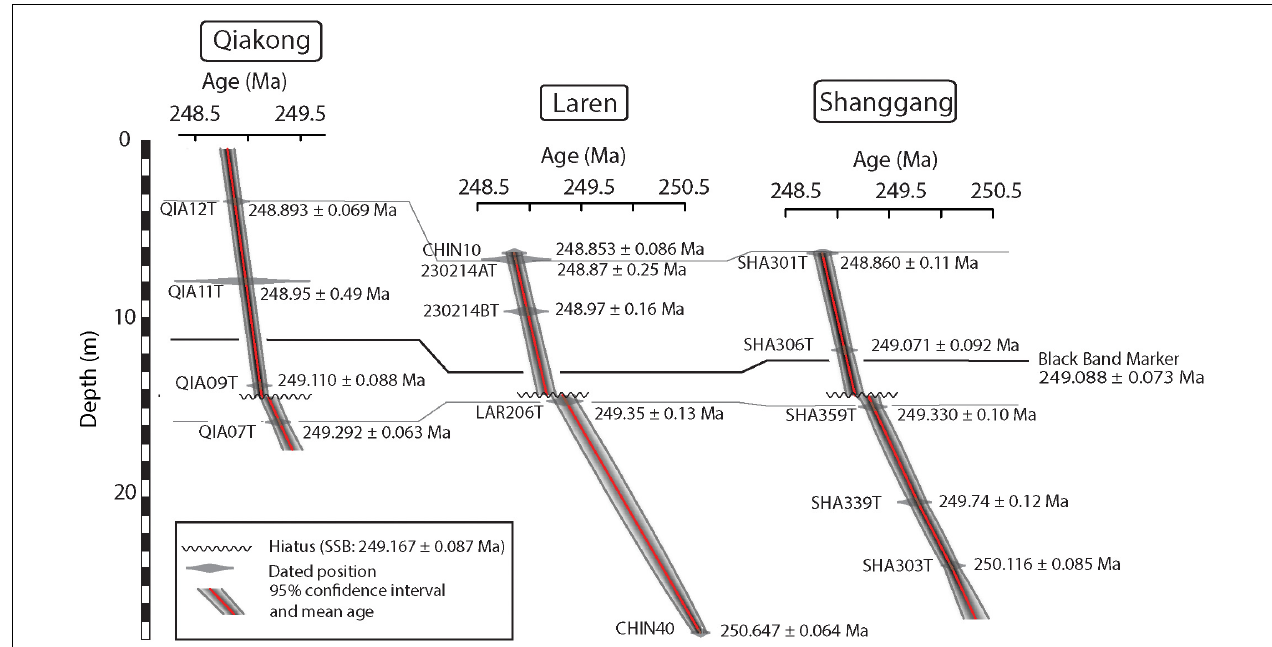
FIGURE 4 | Bayesian “rbacon” age models for Qiakong Laren and Shanggang. The red line represents the model mean age with its error envelope at 95% confidence interval in gray. Data are reported as Th-corrected 206 Pb/ 238 U ages with 2 σ internal uncertainty. Two groups of ash layers yielded ages that overlap within error, thus allowing the positioning of two time-lines: a first line including QIA07T, LAR206T, and SHA359T at the top of the late Smithian Unit IVb, and a second line linking QIA12T, CHIN10, and SHA301T of late early Spathian age at the lower boundary of Unit Vc. The position and age of the “Black Band Marker,” an isochronous 10–15 cm thick shale layer 1.0 to 3.5 meters above the boundary between units Va and Vb in Qiakong ( Figure 1 ) is indicated as well. The base of the nodular limestone rests upon an unconformity and is interpolated from all three sections at an age of 249.167 ± 0.087 Ma.